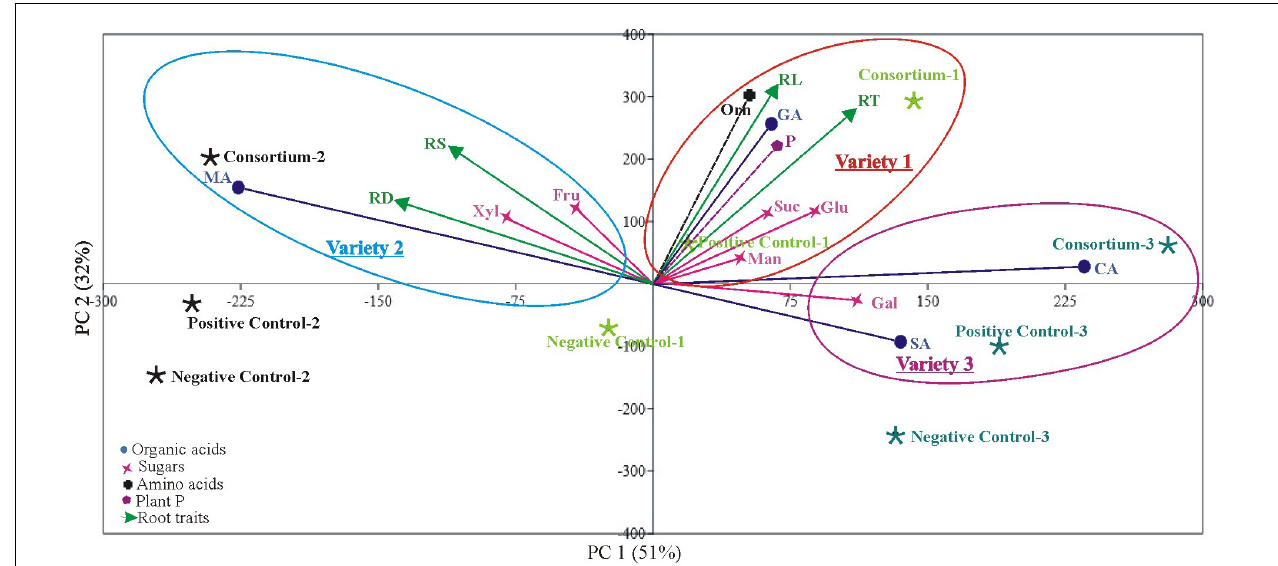
FIGURE 6 | Principal component analysis of root parameters (root exudation and root architecture) and plant P across different wheat varieties in response to PSB inoculation. The first two components explain most of the variation found in the dataset (PC1 and PC2) in wheat variety 1, variety 2, and variety 3. The points represent mean values of each combination of plant P, root exudates, root morphological parameters in correlation to different treatments (inoculation, positive control, and negative control). Loadings (arrows, circles, star, and boxes) indicate directions and strength of parameters in the dataset. RT: Root tips, RD: Root diameter, RS, Root surface area; RL, Root length; GA, Gluconic acid; MA, Malic acid; CA, Citric acid; SA, Succinic acid; Fru, Fructose; Gal, Galactose; Glu, Glucose; Man, Mannose; Suc, Sucrose; Xyl, Xylose and P; Plant phosphorous. Variety 1, Faisalabad-08; Variety 2, Fakhr-e-Sarhad; Variety 3,